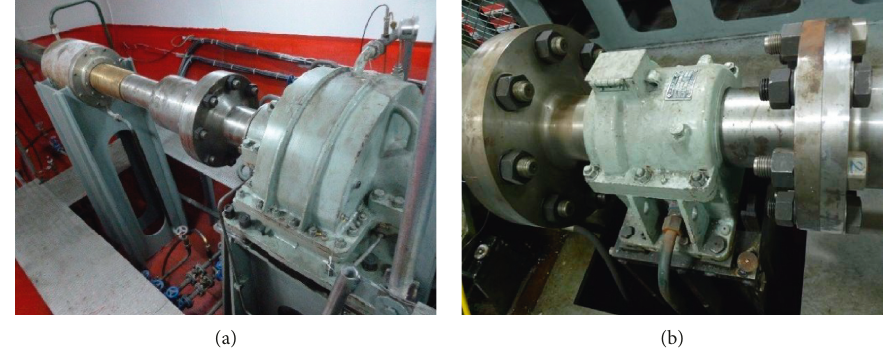
Figure 8: The physical picture of the shafting system.